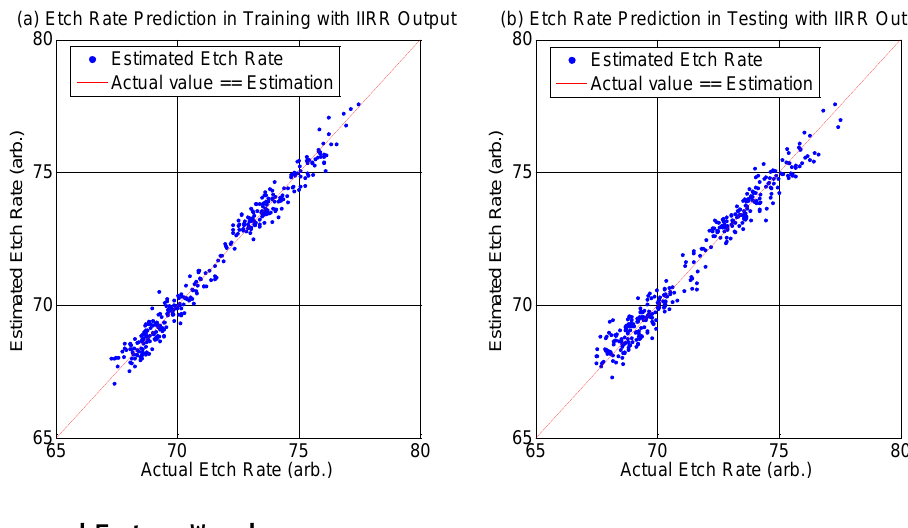
Figure 6. Individual etch rate predictions from the IIRR reduced dataset using